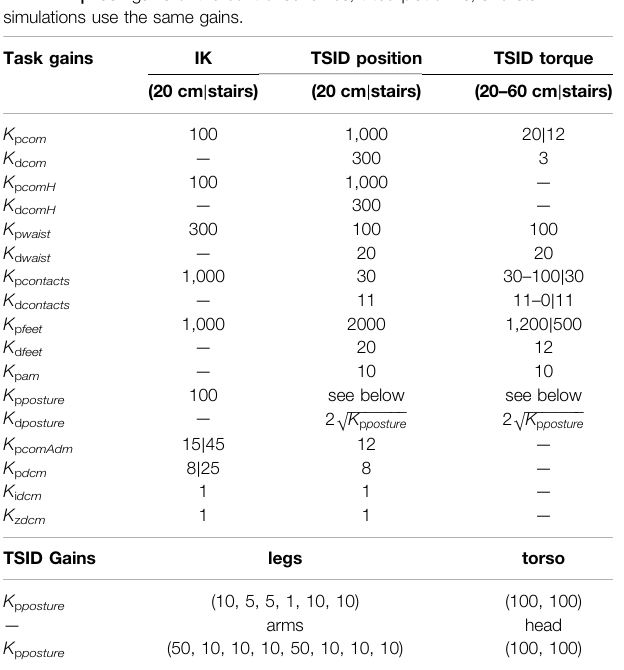
priori heuristic.